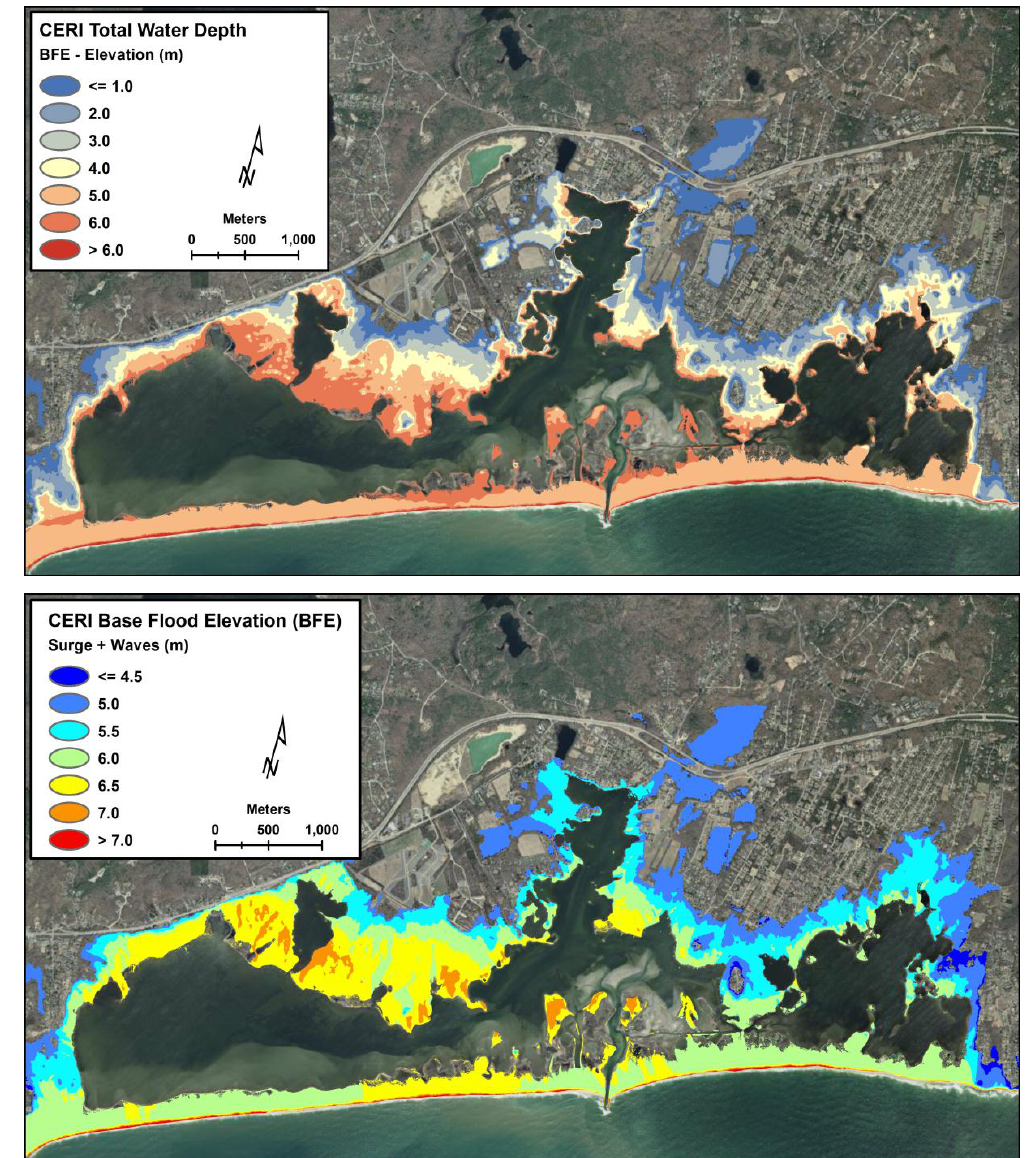
yellow, #19 (left) and #20 (right). Area of substantial increase in BFE near the shoreline from one side of transect #20 to the other (red circle).